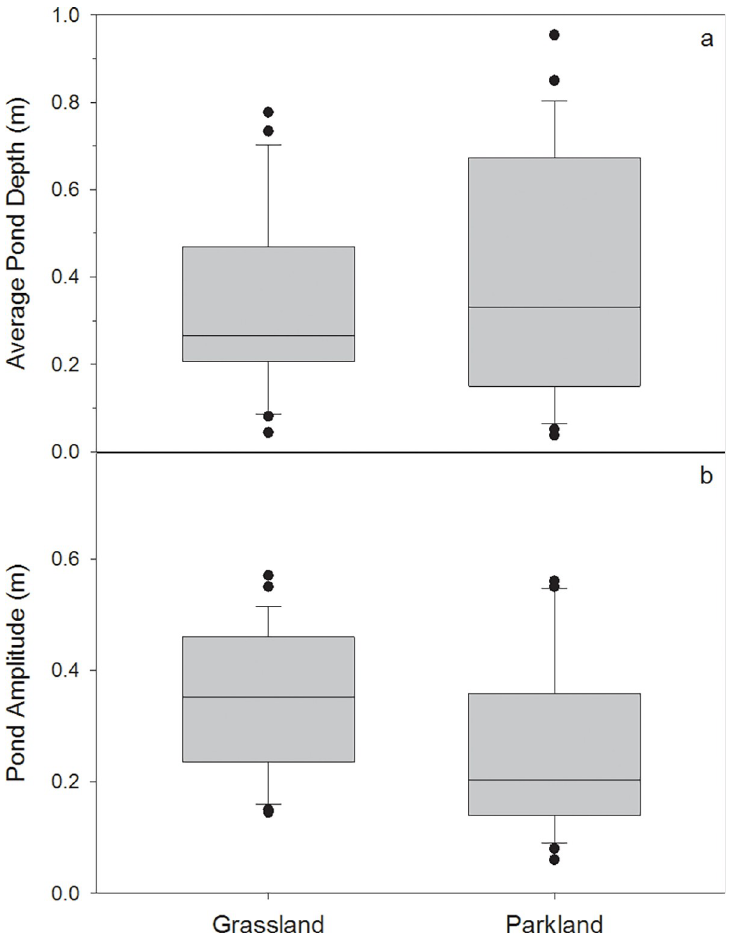
Fig 4. Comparison of a) average pond maximum depth measured in May 2014; and b) pond seasonal amplitude (i.e., seasonal maximum depth minus seasonal minimum depth, measured at the wetland’s deepest point) of wetlands in the Grassland ( n = 24) and Parkland ( n = 24) natural